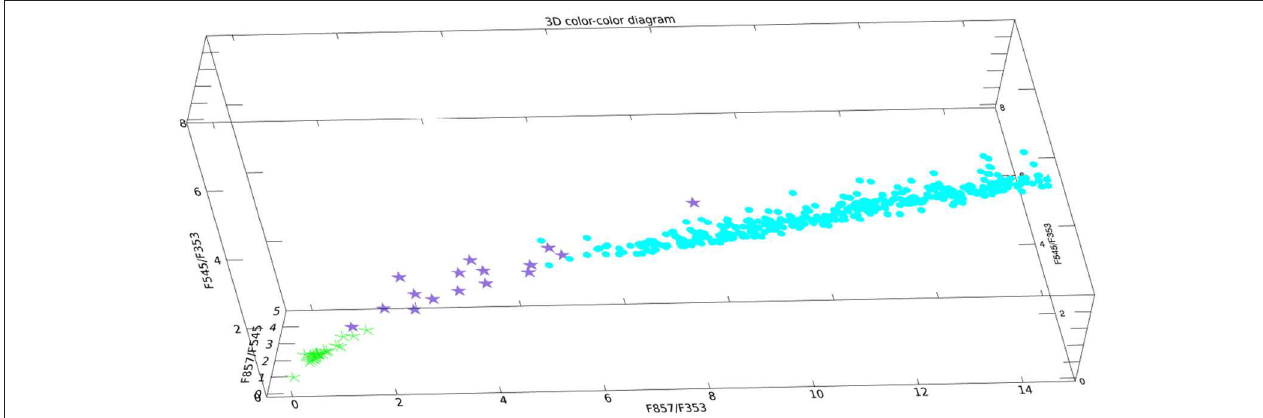
FIGURE 4 | 3D color-color plot showing the colors of strongly-lensed galaxies detected by Planck (purple stars) compared to those of local galaxies (light blue symbols) and of radio sources (green symbols). The distribution of local galaxies extends to the blue far beyond the chosen boundaries of the figure. Strongly lensed galaxies populate a region intermediate between those of local galaxies and radio sources and well distinct from